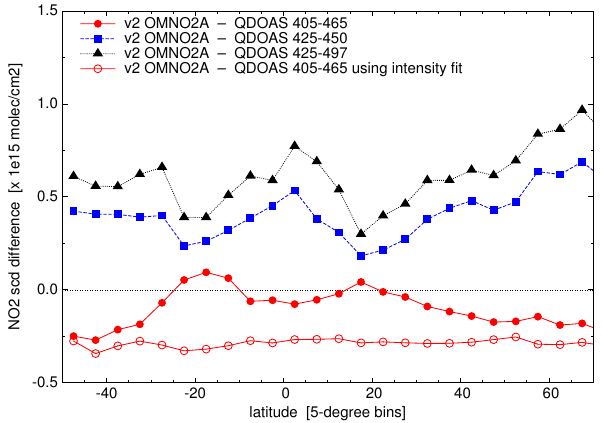
Figure 11. Differences of the NO 2 SCD values of the new v2 Fig. 11. Differences of the NO 2 SCD values of the new v2 OMNO2A fit results (i.e. the red line with circles inFig.6)withQDOASretrievalsusingdifferentfitwindowswithalinearfittingapproach(filledsymbols)and OMNO2A fit results (i.e. the red line with circles in Fig. 6) with usinganon-linearfittingapproachinthestandardfitwindow(opencircles)forthePacificOceantestorbit. The QDOAS retrievals using different fit windows with a linear fitting sizeofthestepsalongtheverticalscaleisthesameasinFig.4toeasecomparisonoftheSCDdifferences. approach (filled symbols) and using a non-linear fitting approach in the standard fit window (open circles) for the Pacific Ocean test or- bit. The size of the steps along the vertical scale is the same as in Fig. 4 to ease comparison of the SCD